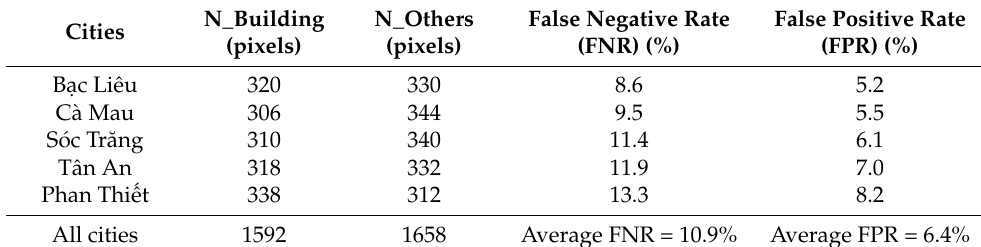
Table 3. Accuracy